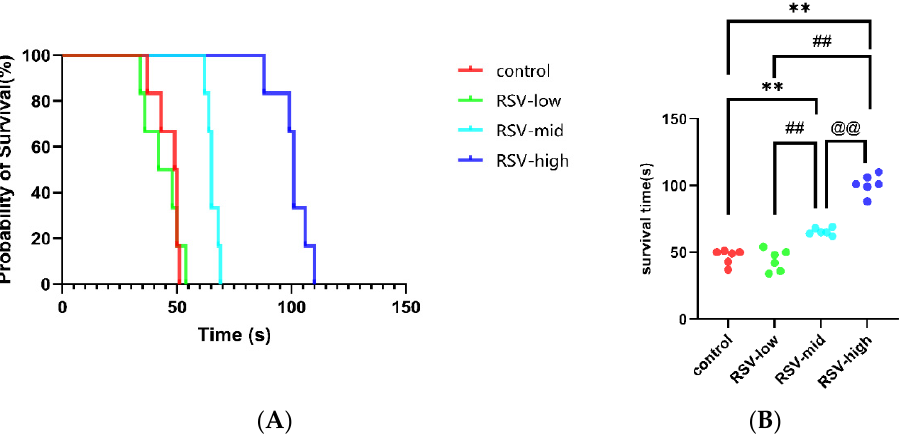
Figure 4. The survival times of mice injected with RSV under acute hypoxic asphyxia: ( A ) probability of survival in acute hypoxic asphyxia; and ( B ) changes in survival times of mice injected with different concentrations of RSV under acute hypoxic asphyxia. Note: **, vs. control, p < 0.01; ##, vs. RSV-low, p < 0.01; @@, vs. RSV-mid, p < 0.01.